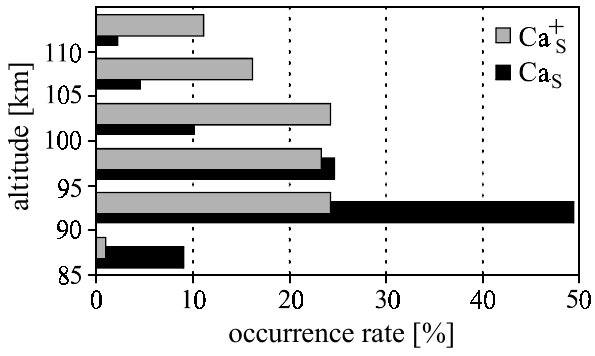
Fig. 7. Altitude distribution of sporadic Ca and Ca + layers as listed in Table 1 (columns 2 and 3).